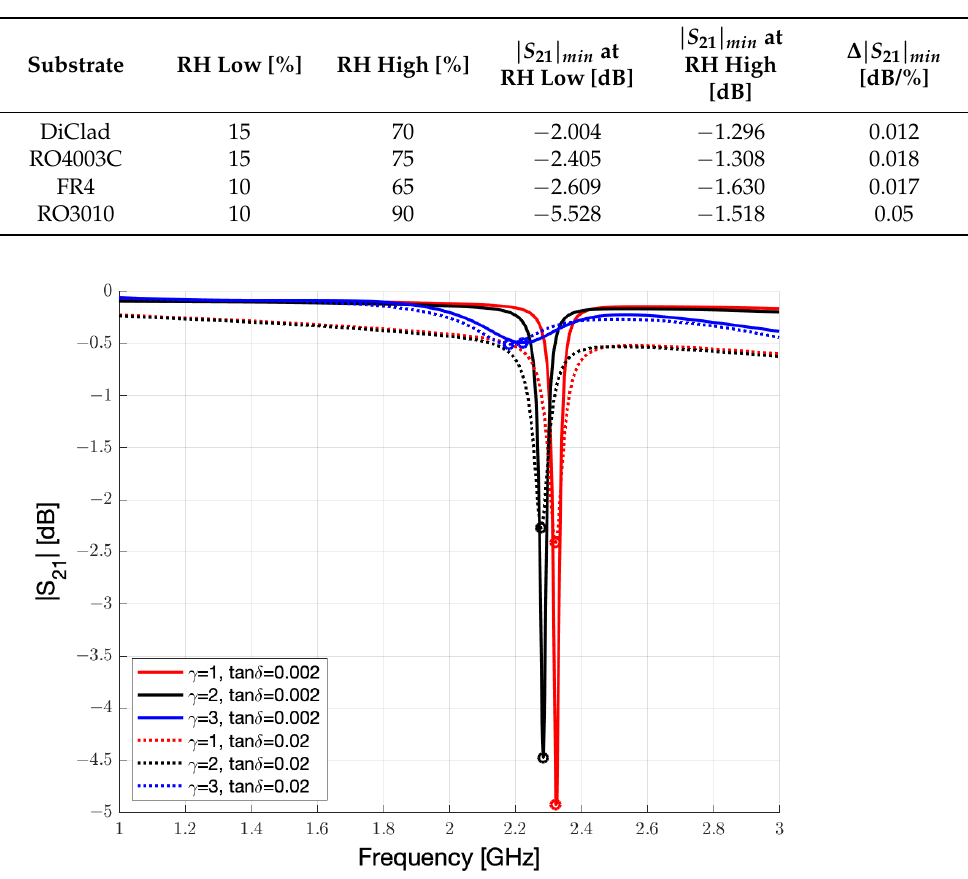
Table 4. Performance comparison in terms of signal amplitude variation [dB/%] of the chipless humidity sensor proposed on the different substrates.